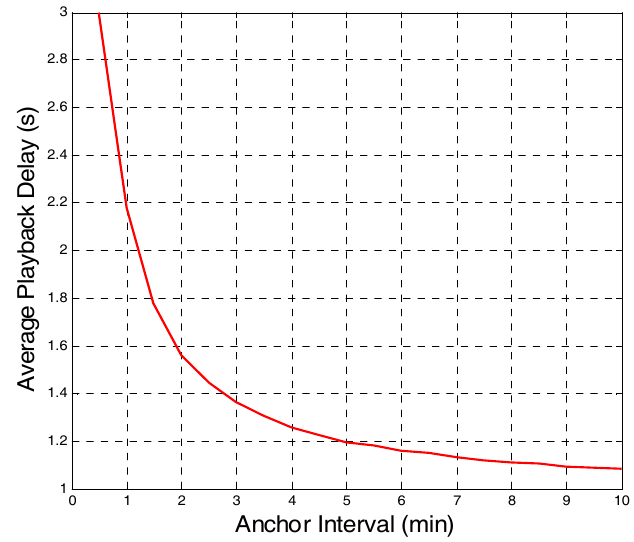
Figure 3. Average playback delay with different anchor intervals.